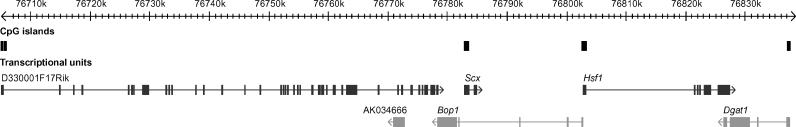
A Five-TU Chain on Mouse Chromosome 15TUs on the genomic plus and minus strands are shown in dark gray and light gray, respectively (boxes represent exons). CpG islands are shown as black boxes. From left to right, the chain contains a member of the aminoacyl tRNA transferase class II family (D330001F17Rik), which has two cis–antisense transcripts: fully overlapping (cDNA AK034666) and convergent (Bop1). The latter encodes a ribosome biogenesis protein and shares a CpG-island bidirectional promoter with the heat-shock-induced transcription factor 1 gene (Hsf1). Hsf1, in turn, is convergently cis–antisense to the diacylglycerol O-acyltransferase 1 gene (Dgat1).